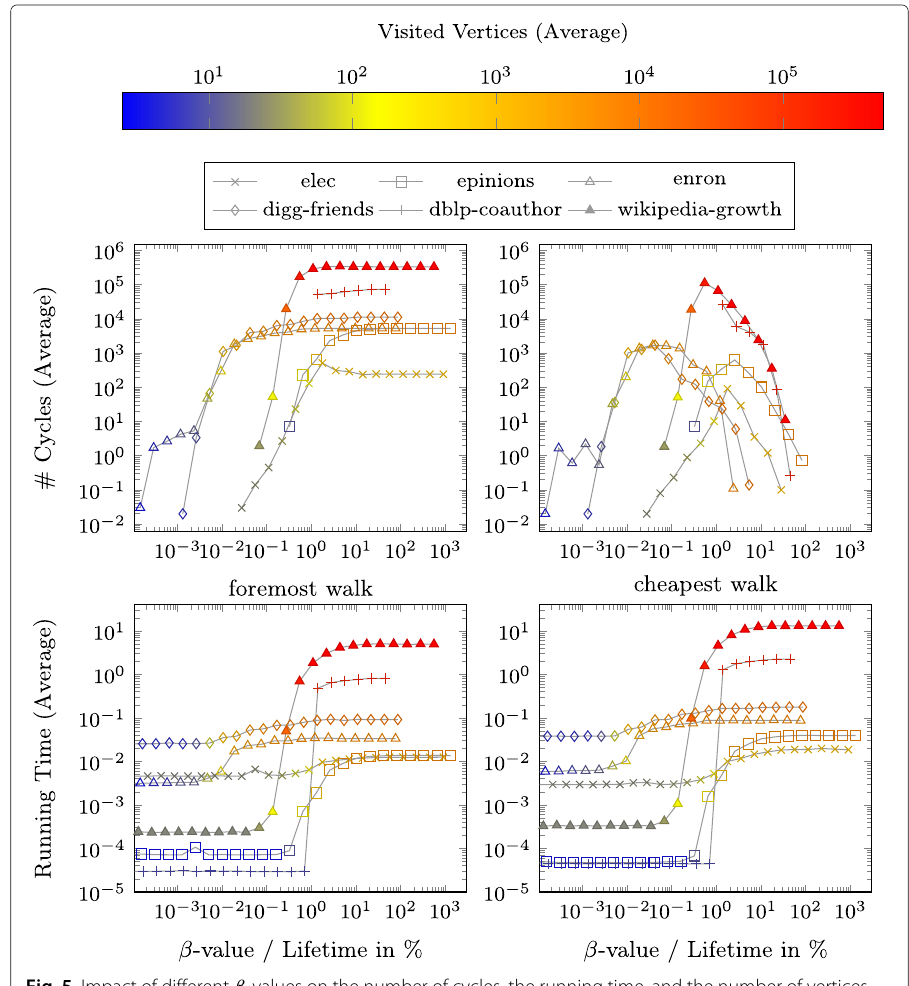
Fig. 5 Impact of different β -values on the number of cycles, the running time, and the number of vertices that can be reached by temporal walks from the chosen starting vertices. Each data point represents 100 runs for a specific β -value for randomly selected starting vertices in the same graph (the same vertices where used for all β -values). The symbol of the data point represents the input graph, the color represents the average number of visited vertices, and the x-coordinate represents the chosen β -value (for the sake of comparability in terms of β -value divided by the graphs lifetime). The y-coordinate represents in the two upper plots the average number of cycles in optimal walks to all reached vertices and in the bottom two plots the average running time for each source vertex. A line connects all data points that use the same graph. The two plots on the left side show results for foremost walks and the two plots on the right side show results for cheapest